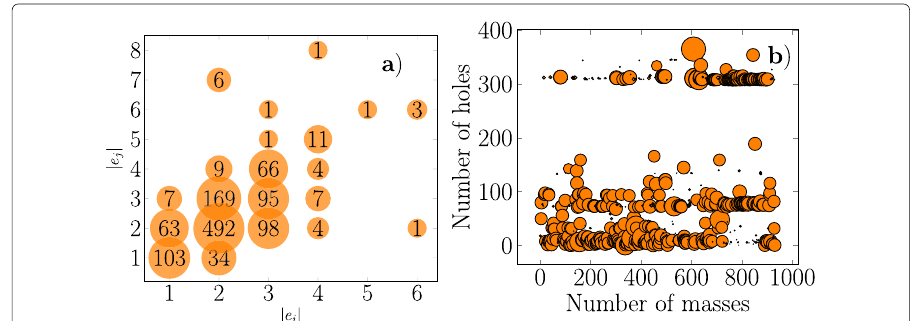
Fig. 7 Metabolic hypernetwork of E.coli . a distribution of tail and head sizes. b Distribution of number of masses and holes